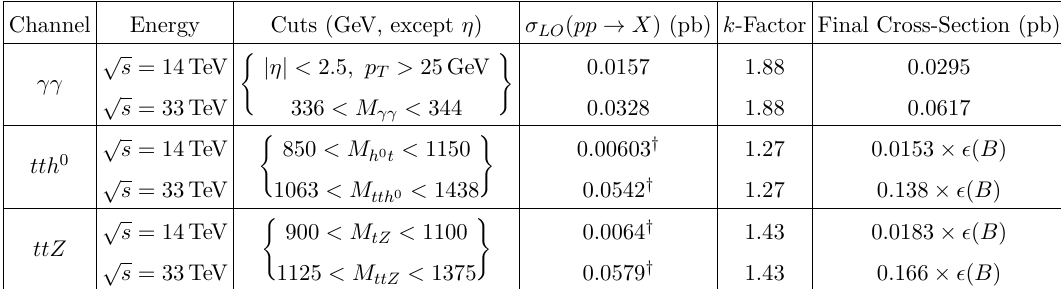
Table 3. Table of cross-sections and cuts on SM background processes in various channels, which will compete against the φ boson signal in these channels shown in the previous table, where the suggested cuts are designed to enhance the signal.